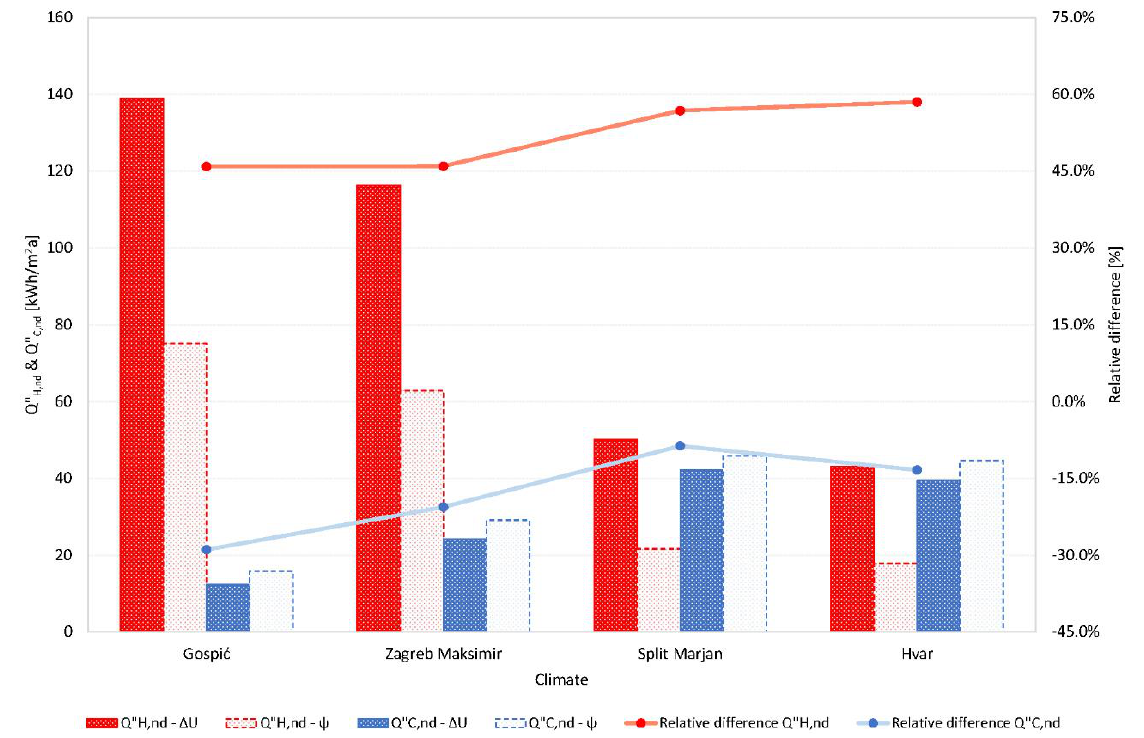
Figure 11. Heating and cooling energy needs depending on the thermal bridge consideration ap- proach.